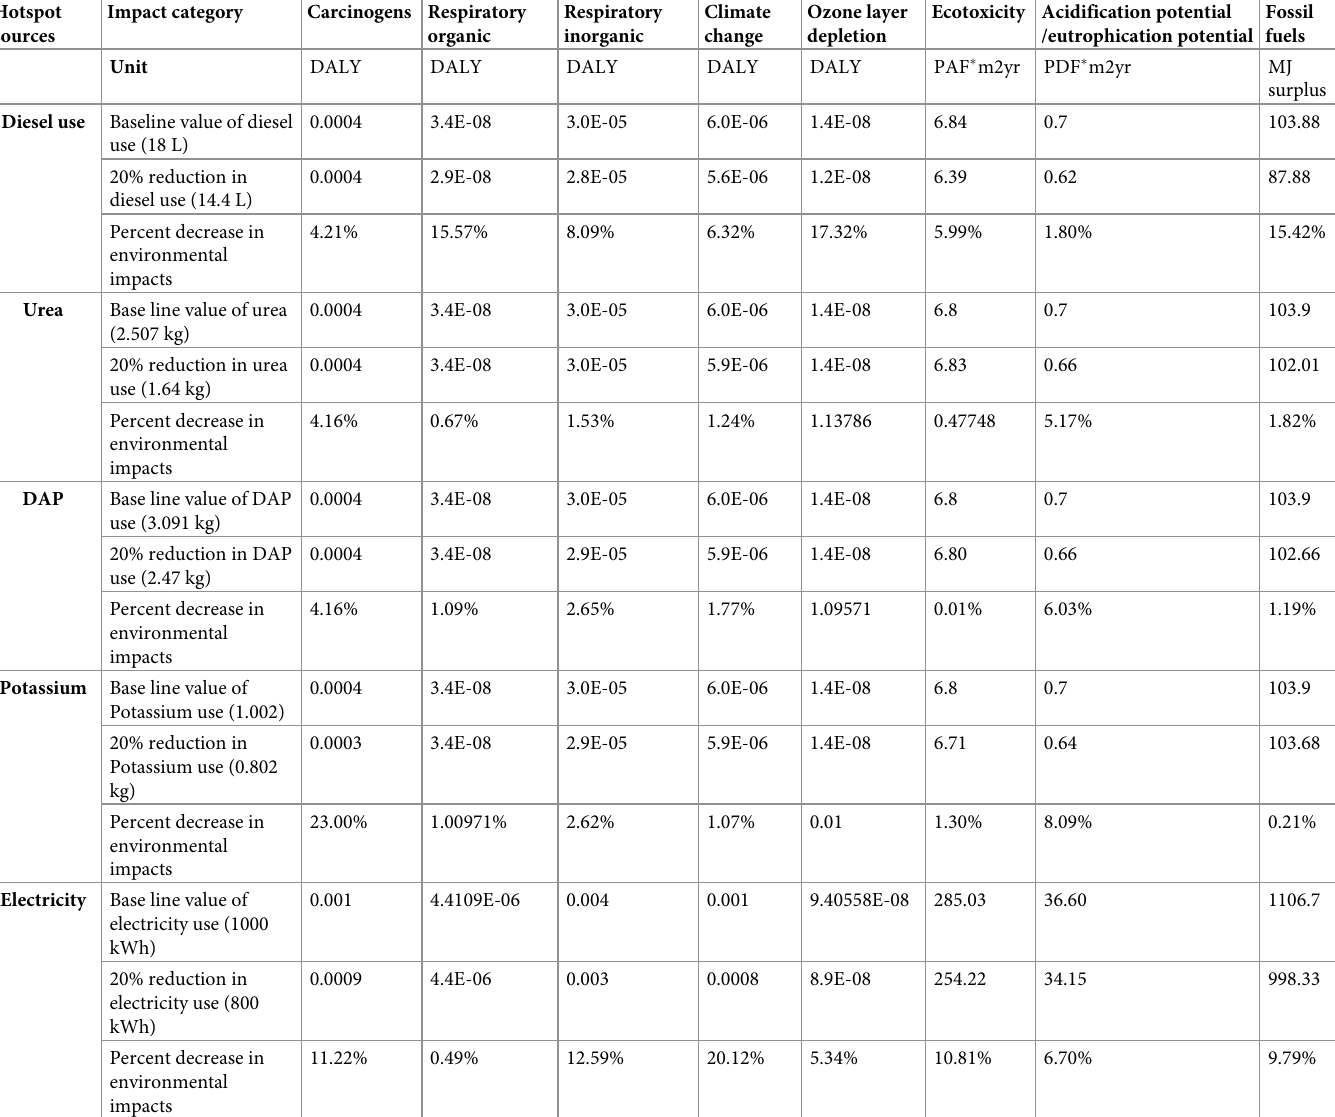
Table 4. Comparative environmental impacts assessment of baseline results with the results obtained by 20% reduction in the following inputs